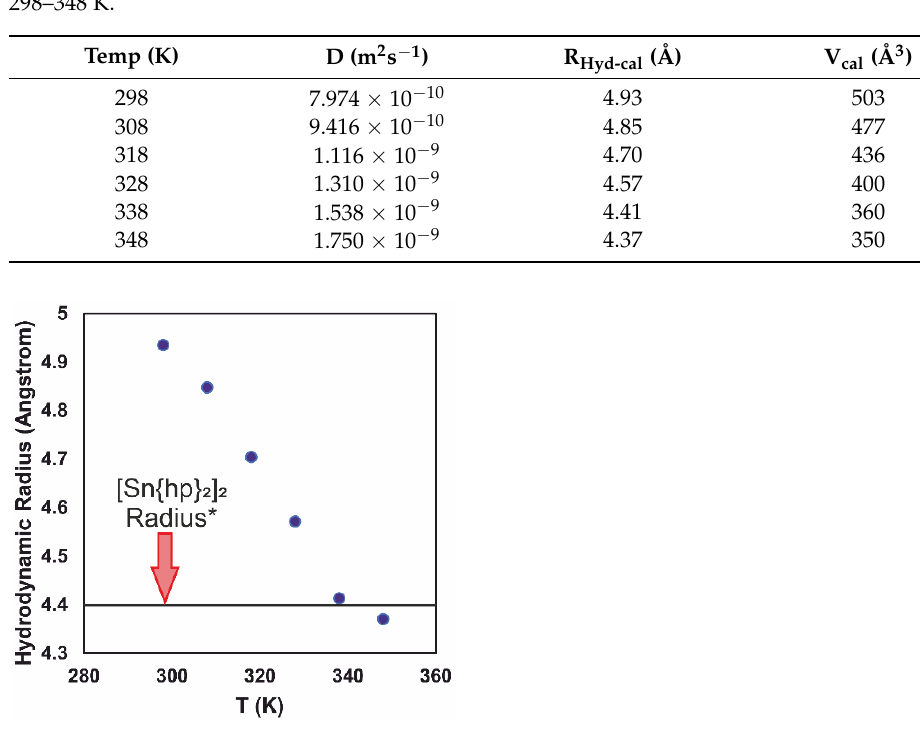
Figure 4. Graph showing the experimentally determined diffusion coefficients of 2 , 5.43 mM in d 8 - Tol, as a function of temperature. * : Radius (4.44 Å ) as determined by single-crystal X-ray diffrac-